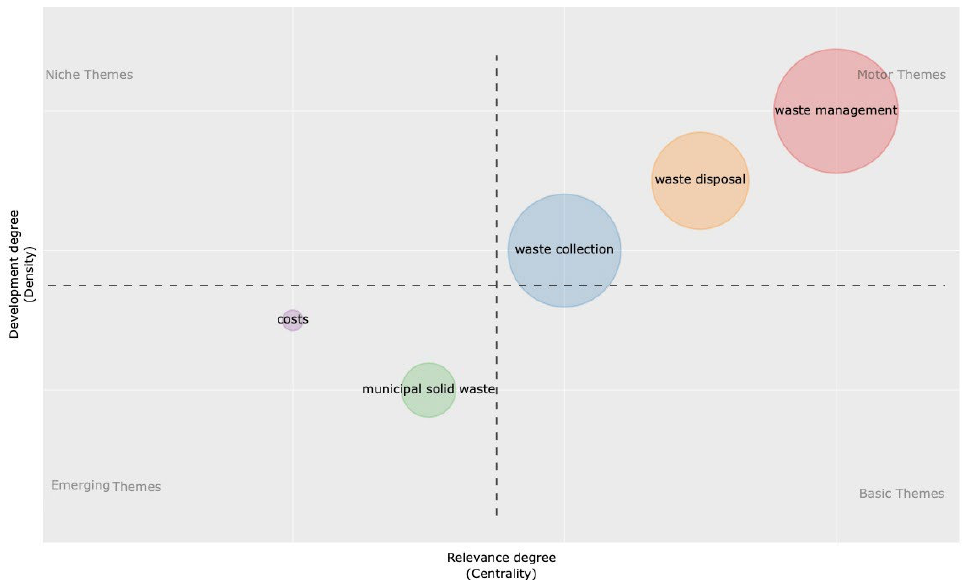
Figure 7. Thematic map during the period 2009–2022 using R-studio software and bibliometrix li- brary.